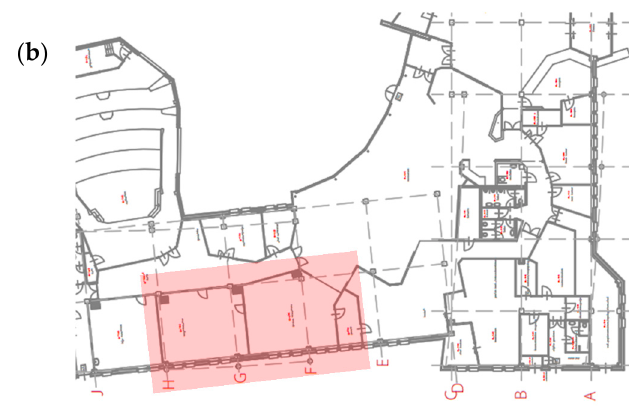
Figure 5. The datasets for two different epochs. The first row is the dataset which belongs to the Braunschweig building and the second row is from the ITC building and is a more complex dataset, with furniture and large glass windows.